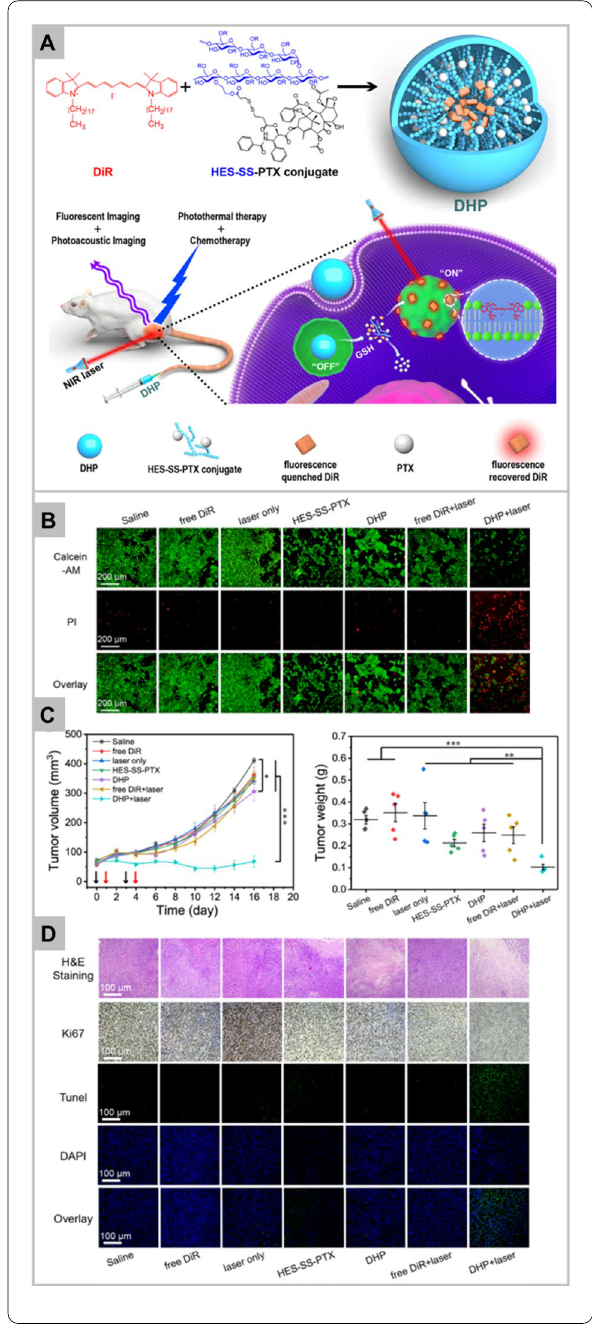
Fig. 3 Schematic illustration of the DHP structure and multiple theranostic applications. Therapeutic efficacy of DHP (Panel A ). Chemo-photothermal cytotoxicity of DHP on 4T1 tumor cells, determined by the live/dead assay. The scale bars are 200 μm and applied for all images (Panel B ). Tumor volume and excised tumor weight of 4T1 tumor-bearing BALB/c mice after different treatments. Black arrows represent i.v. administration of various formulations, while red arrows represent laser irradiation (Panel C ). H&E staining, ki67 immunohistochemistry, and TUNEL fluorescence staining of tumor sections at the end of the in vivo antitumor experiment. The scale bars are 100 μm and applied for all images (Panel D ). Data in B and C represent mean SEM n 5; *p < 0.05; **p < 0.01; ***p < 0.001. ± = Reprinted with permission from Nanoletters, Copyright 2019, American Chemical Society